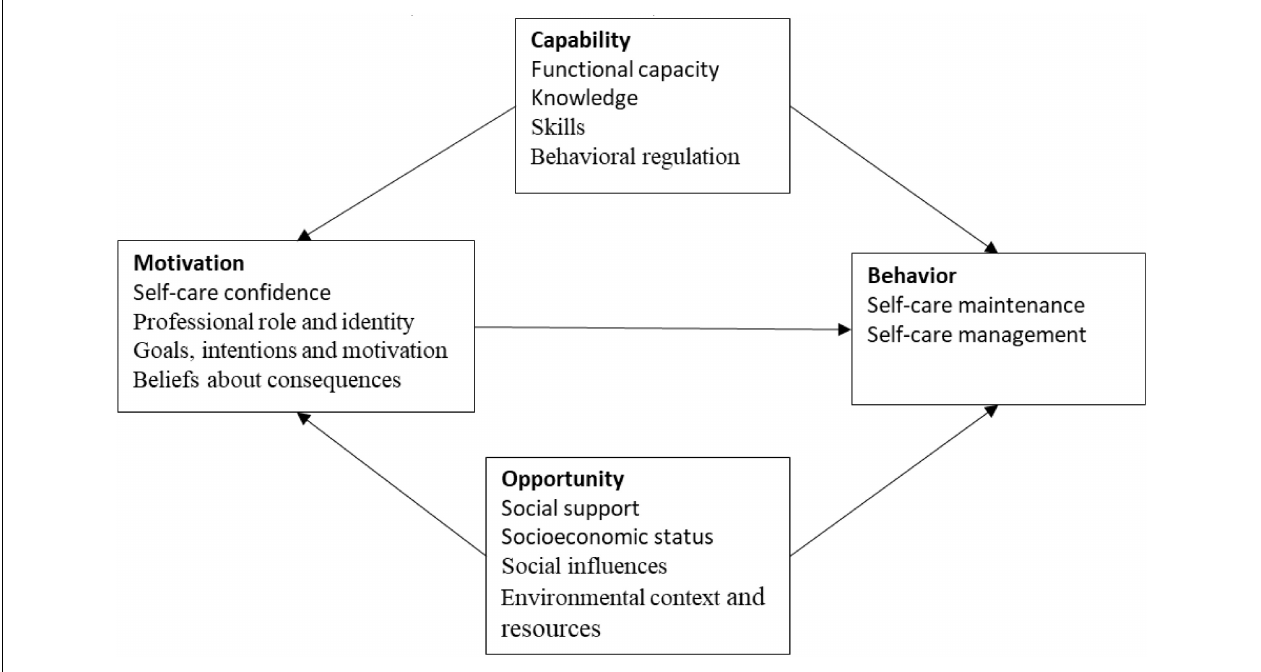
FIGURE 1 | COM-B research conceptual